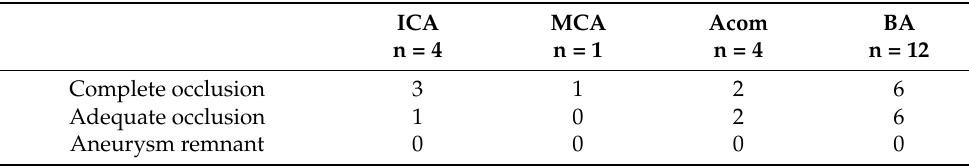
Table 3. Aneurysm occlusion degree in relation to its position at 2-year follow-up.